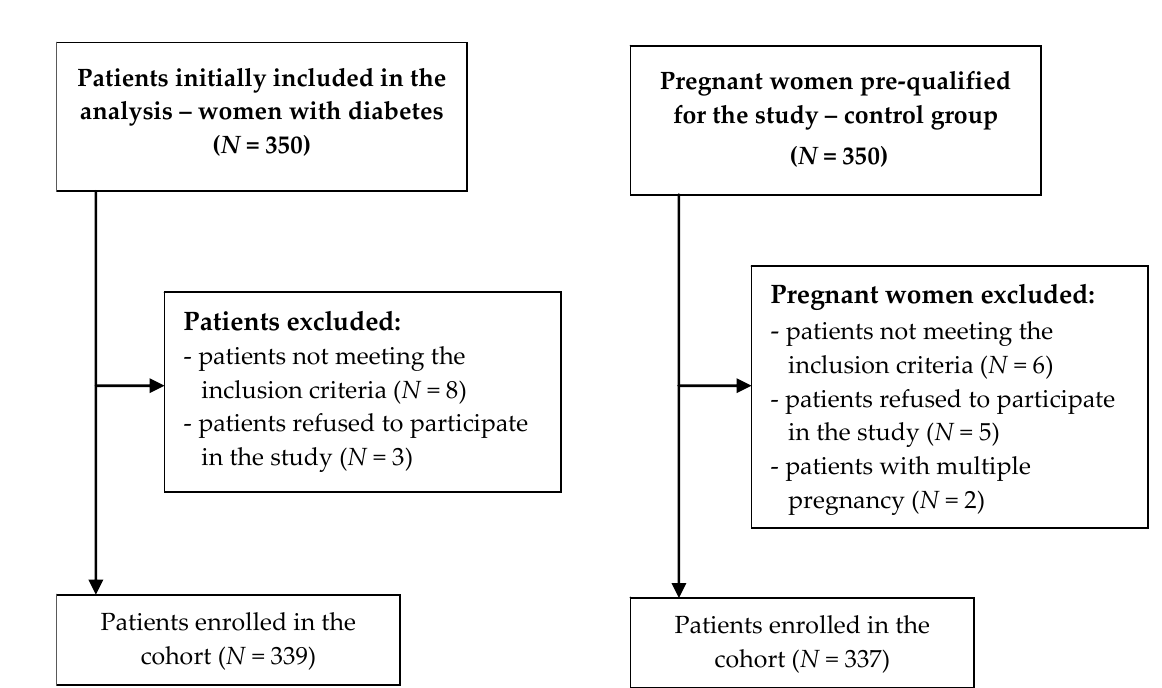
Figure 1. Flowchart of the recruitment process of the patients.